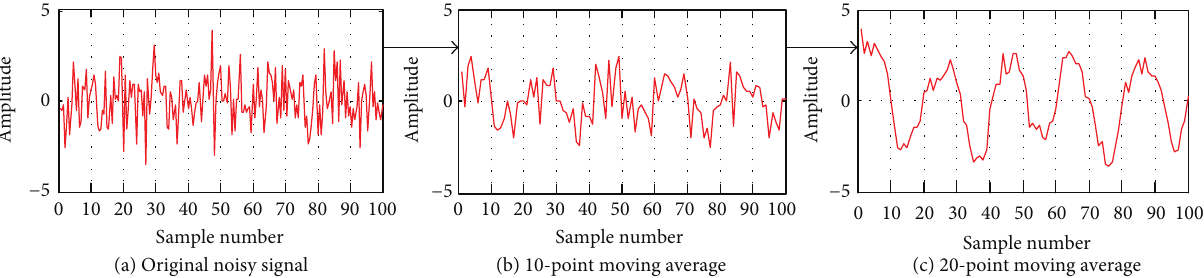
Figure 5: Example of a moving average filter. In (a), random noise signal. In (b) and (c), this signal is filtered with 10- and 20-point moving average filters buffer